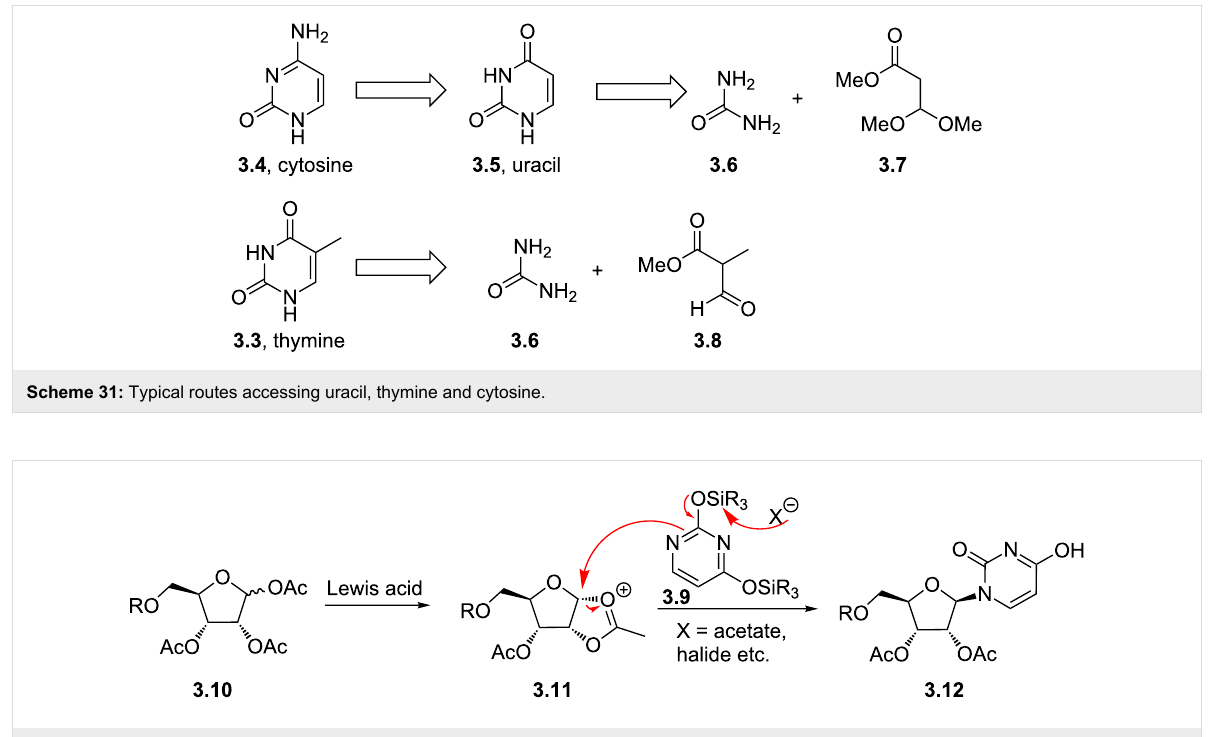
Scheme 32: Coupling between pyrimidones and riboses via the Vorbrüggen nucleosidation.